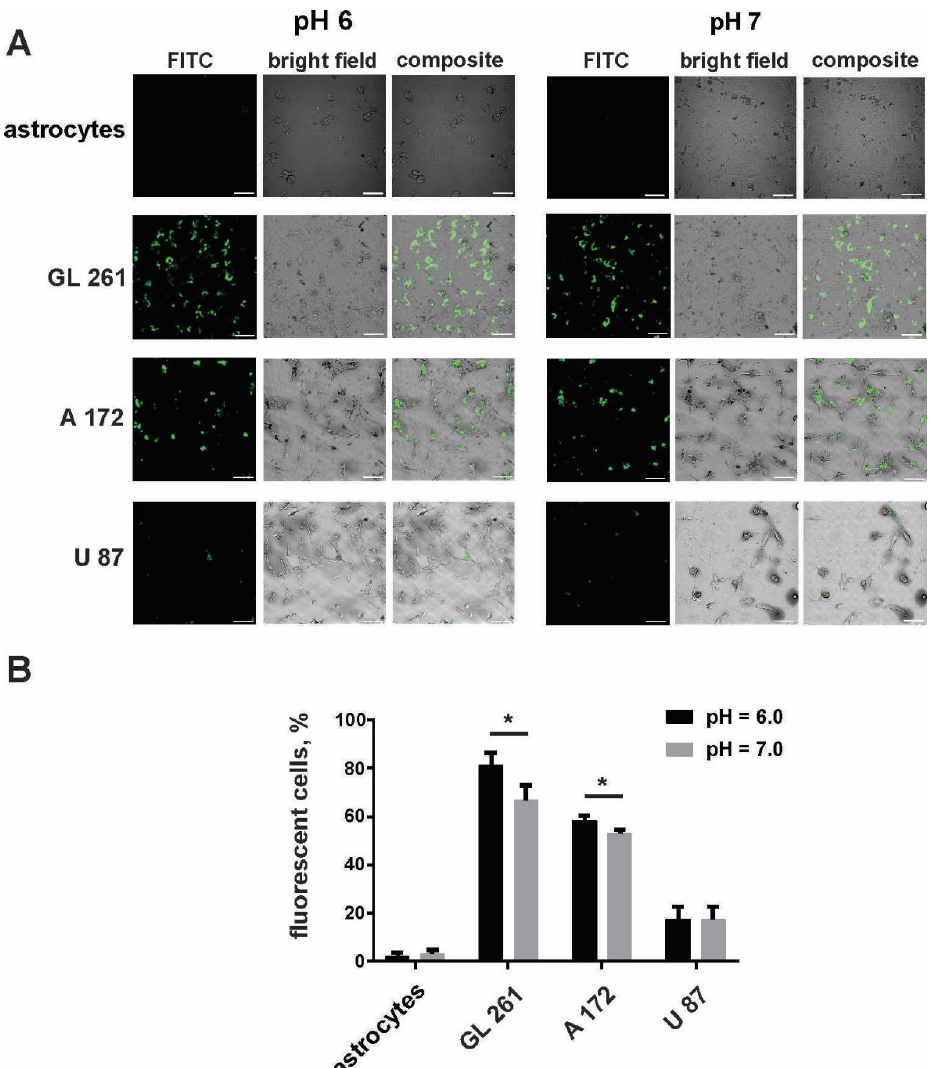
Figure 1. Some cultured glioma cells specifically take up FA-Cyt c NP constructs. Confocal images ( A ) and calculation ( B ) of live glioma cells and mouse primary cultured astrocytes were made after six hours of incubation with fluorescein isothiocyanate (FITC)-conjugated FA-Cyt c NPs at a concentration of 100 µ g / mL. Mean ± S.E.; significant di ff erences from control (*) are shown ( p < 0.05). N = 3 ( N is the number of the experimental repeats per cell culture). Scale bar, 50 µ